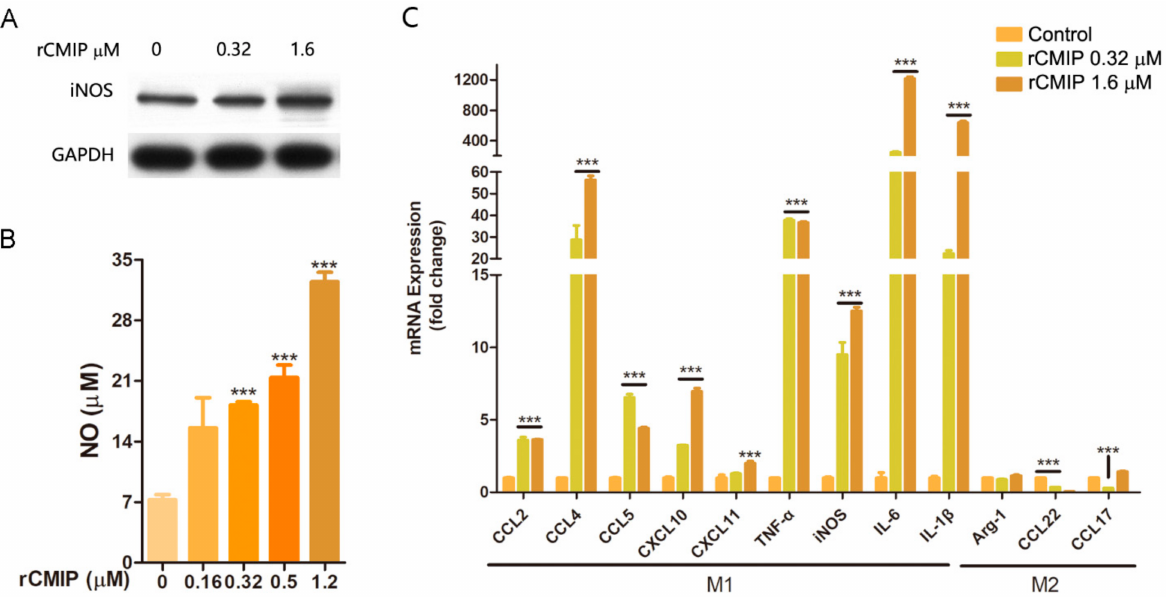
Figure 5. Effects of rCMIP on the polarization of RAW 264.7 cells. ( A ) iNOS protein expression of RAW 264.7 cells treated by rCMIP (0 µ M, 0.32 µ M and 1.6 µ M) was analyzed by Western blot. ( B ) The release of NO in response to rCMIP (0 µ M, 0.16 µ M, 0.32 µ M, 0.5 µ M and 1.2 µ M) treatment. ( C ) RAW 264.7 cells were treated with rCMIP (0 µ M, 0.32 µ M and 1.6 µ M) for 3 h. The mRNA expression fold changes of M1 polarization mRNA (CCL2, CCL4, CCL5, CXCL11, CXCL10, IL-1 β , TNF- α , iNOS and IL-6) and M2 polarization mRNA (Arg-1, CCL22 and CCL17) were tested by q-PCR assay. Data were expressed as the means ± SD ( n = 3) ( *** p <